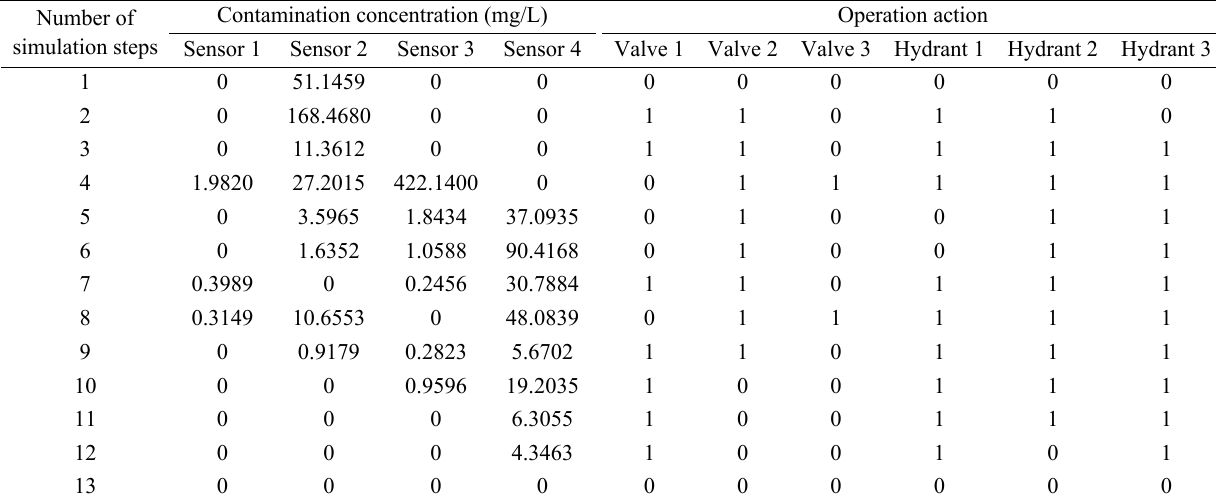
Table 2 Status of sensors, valves, and hydrants for the contaminant event PS5. Number